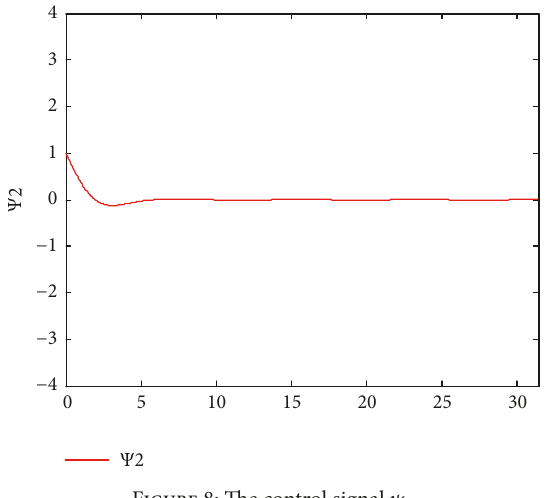
invoked in the steady state of the ESO. Practically, we can choose a group of available parameters 𝑚 1 = 300 , 𝑚 2 = 1 , = 1 , 𝑛 = 0.01 , ] = 1/2 , ] = 1/4 , ℎ = 9 , ℎ = 6 , ℎ = 3 𝑚 3 0 1 2 1 2 3